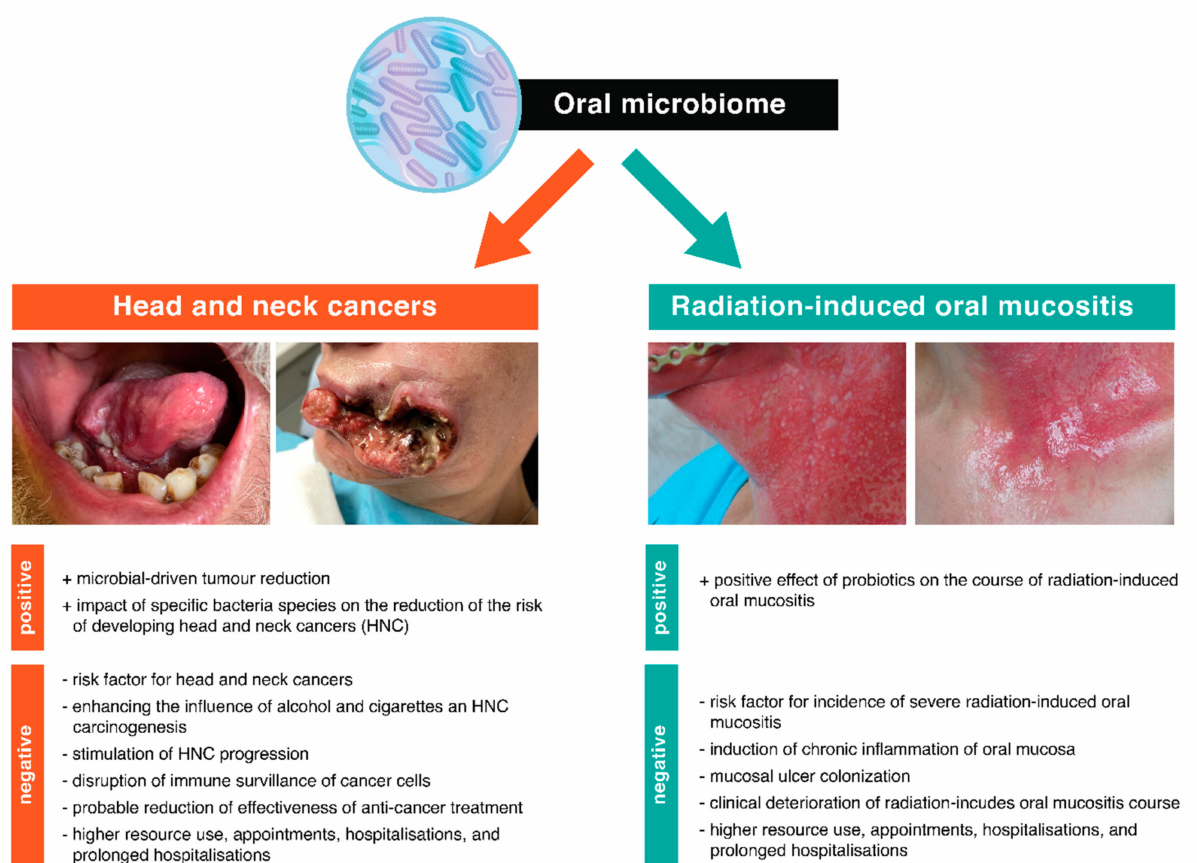
Figure 1. A summary of the effects of the oral microbiome on head and neck cancer and radiation-induce oral mucositis. The figure shows the influence of the oral microbiome on head and neck cancers and radiation-induce oral mucositis, taking into account the positive and negative health effects. A detailed description of the topics discussed in the figure is provided in the